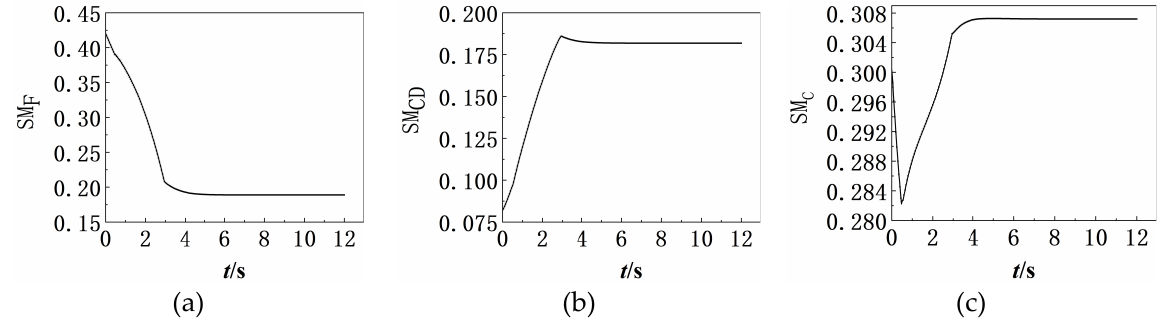
Figure 13. Change curves of surge margin of working-mode switching from double bypass to single bypass at H = 0 km, Ma = 0, ( a ) Surge margin of fan; ( b ) surge margin of CDFS; ( c ) surge margin of HPC.